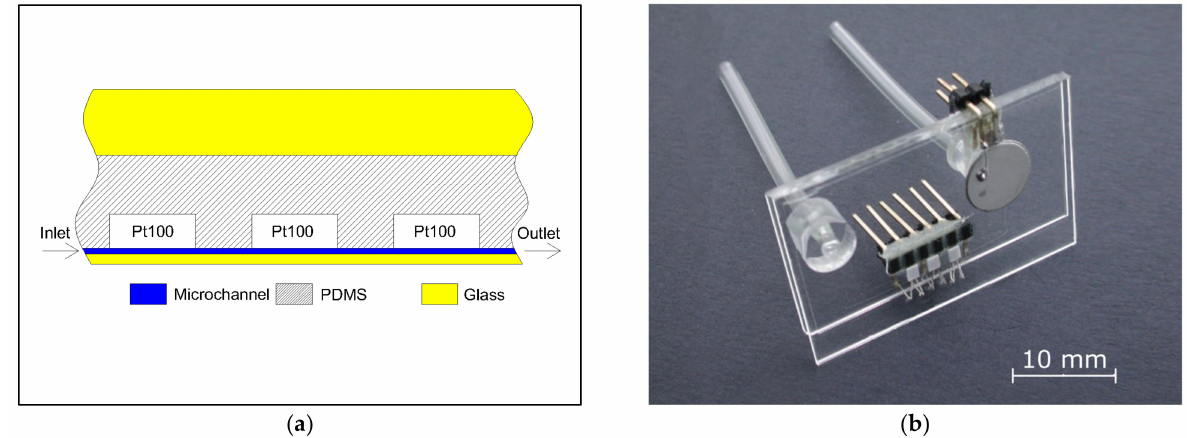
Figure 4. ( a ) A microchannel vertical cross-section of the thermal mass flowmeter with wall mounted Pt100 heating/sensing elements. Dimensions are not to scale; ( b ) a photograph of the fabricated microfluidic chip comprising the thermal mass flowmeter and the